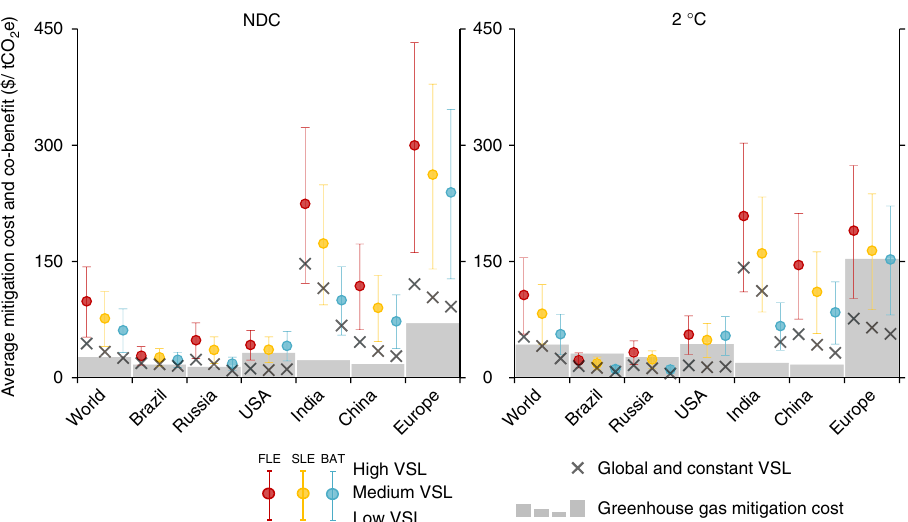
Fig. 6 The value of the co-bene fi ts of improved air quality due to climate polices in NDC and 2 °C scenarios. Values represent the average over 2015 – 2050 for Fixed Legislation (FLE), Stringent Legislation (SLE), and Best Available Technologies (BAT) air quality policies. Co-bene fi ts include the value of avoided premature mortality as well as the co-bene fi ts on the labour and agricultural markets via avoided work days lost and improved crop yields, respectively. The whiskers indicate high, medium, and low value of statistical life (VSL), heterogeneous across regions and time depending on GDP per capita. The black cross indicates results with the value of statistical life of 1.5 million US$(2005) constant across regions and over time. The shaded area presents the costs (change in welfare expressed as equivalent variation) of climate change mitigation policy over 2015 – 2050 and does not consider any co-bene fi ts, nor does it include direct bene fi ts of avoided impacts of climate change. Both cost and co-bene fi ts are expressed per tonne of greenhouse gas emissions reduced excluding land use (change) and